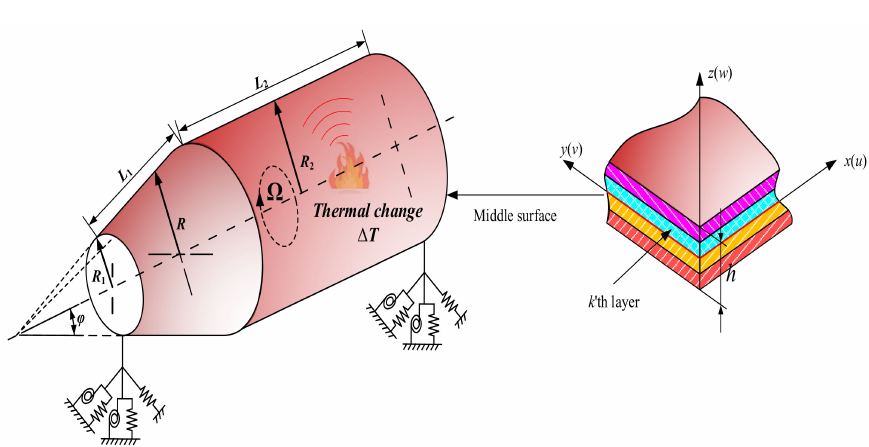
Figure 1. Geometry of rotating cross-ply combined conical-cylindrical shell in thermal